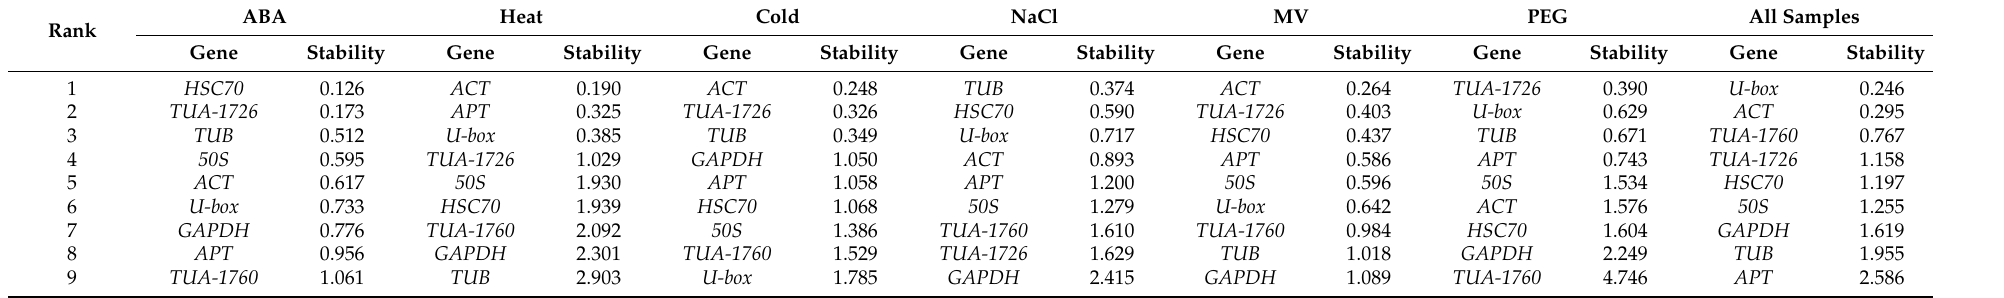
Table 2. Expression stability ranking of all candidate genes under 6 abiotic stresses on NormFinder.